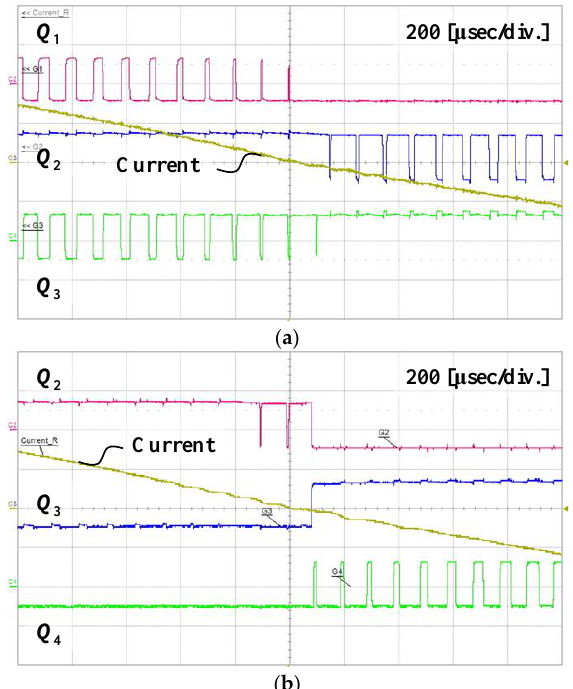
Figure 18. Experimental results in the case where the power factor is controlled at −0.9 (lead) using the proposed switching scheme: ( a ) waveforms of the output voltage and current; ( b ) waveforms of the gate signal.